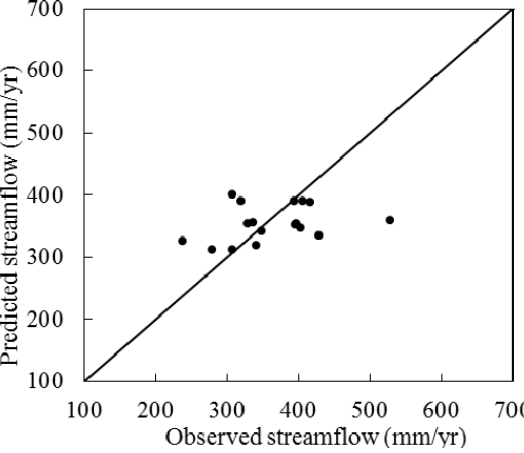
Figure 1. Comparison of observed and calculated (using Fu’s Equation) ET a /P in the study watersheds.